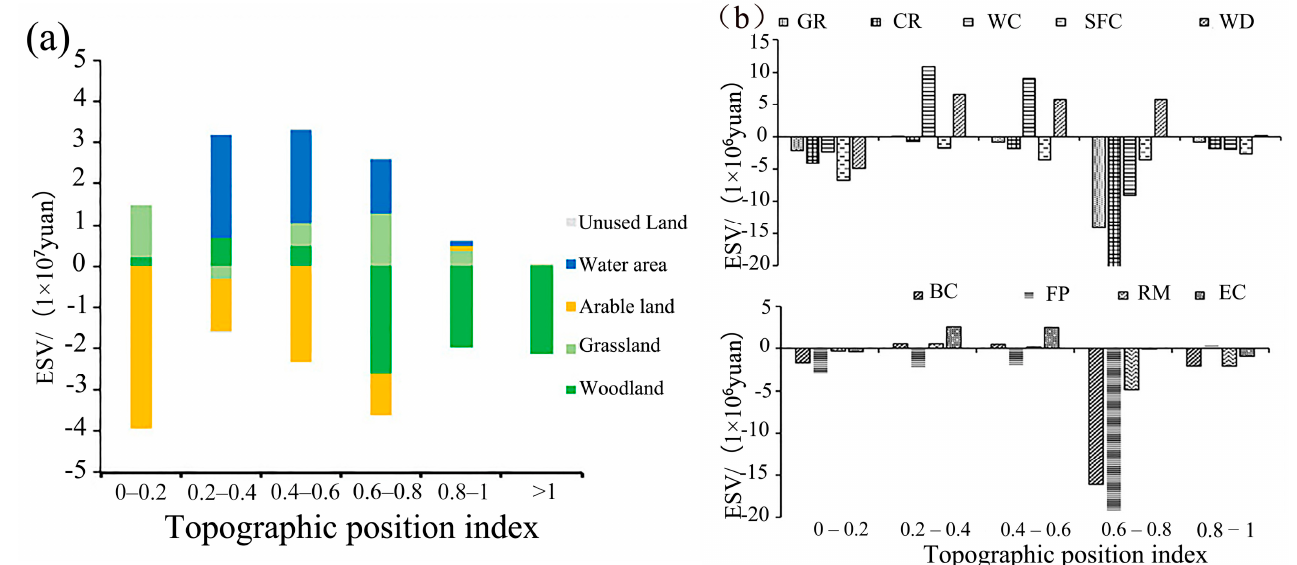
Figure 6. Changes in total ESV ( a ) and individual ESVs ( b ) in the Qihe watershed by topographic position index from 2000 to 2015.